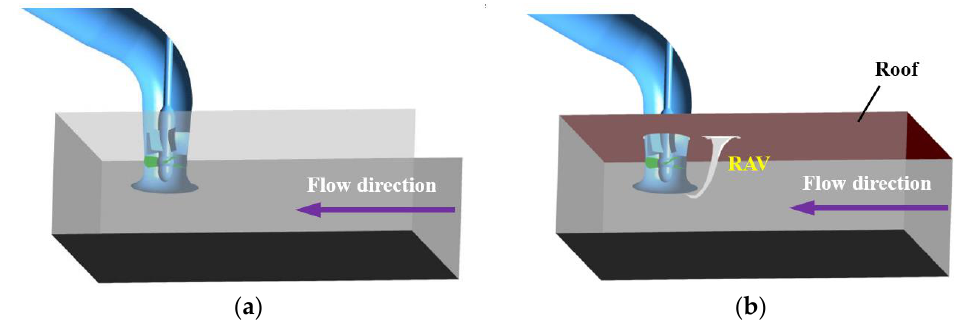
Figure 1. Different types of pump sump. ( a ) open sump. ( b ) closed sump.